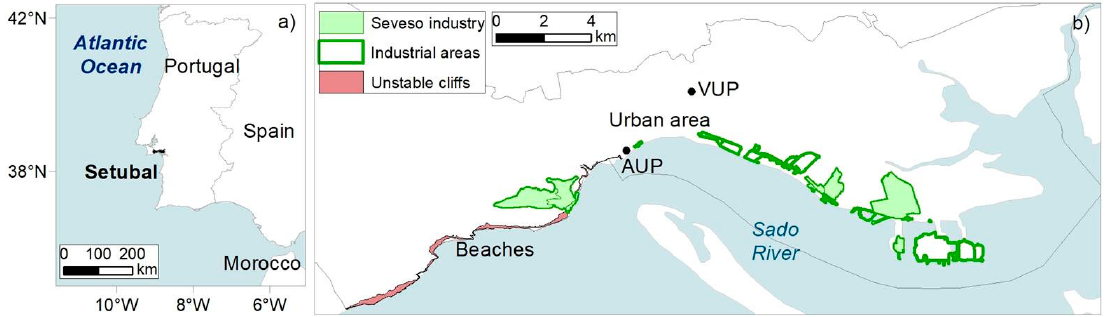
Figure 1. Coastline land use of the studied area: ( a ) Location of Setubal municipality; ( b ) Main areas including the Albarquel Urban Park (AUP) and the Varzea Urban Park (VUP). Adapted from [13,14].